Question: Is the quantity shown trending increasing or decreasing?
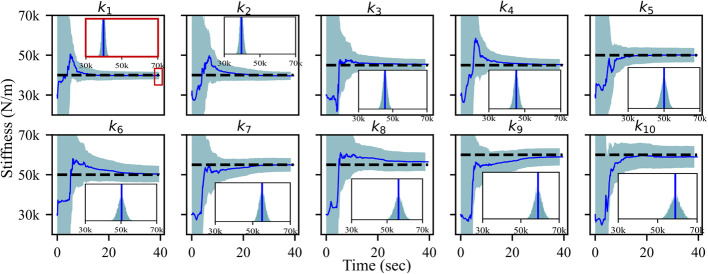
Answer: increasing